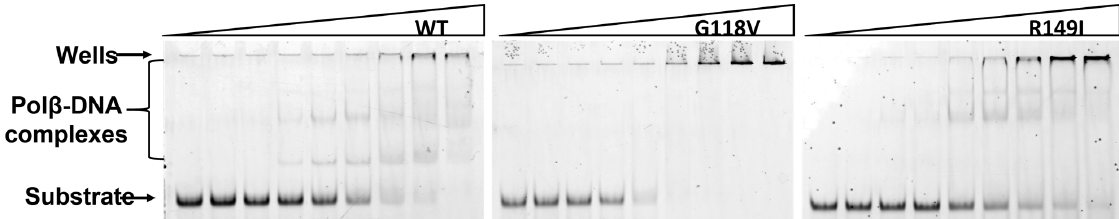
Figure 4. The EMSA of DNA binding by WT Polβ and by polymorphic variants G118V and R149I. The experiments were conducted using serial dilutions of the enzymes. The concentration range was from 2.83 µM to 22 nM for WT Polβ, from 16.4 µM to 130 nM for the G118V variant, and from